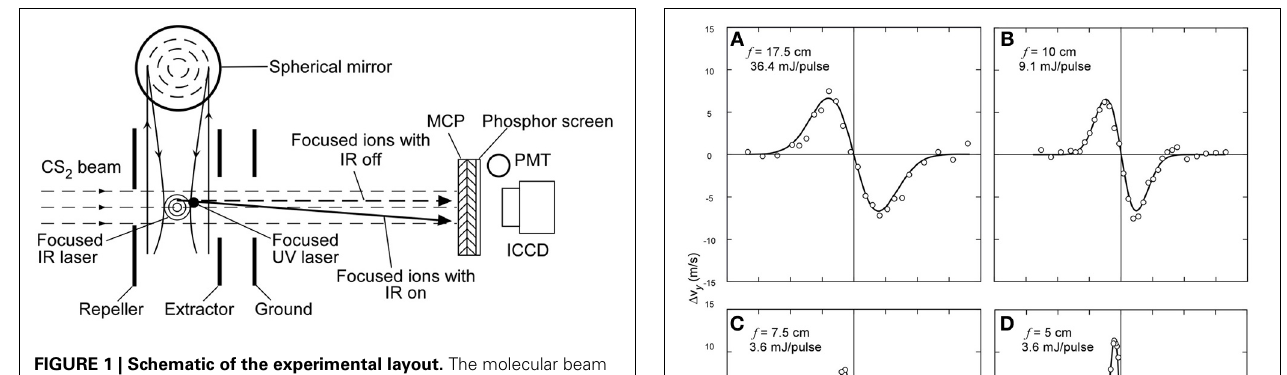
P47 phosphor screen. The pressure inside the detection chamber